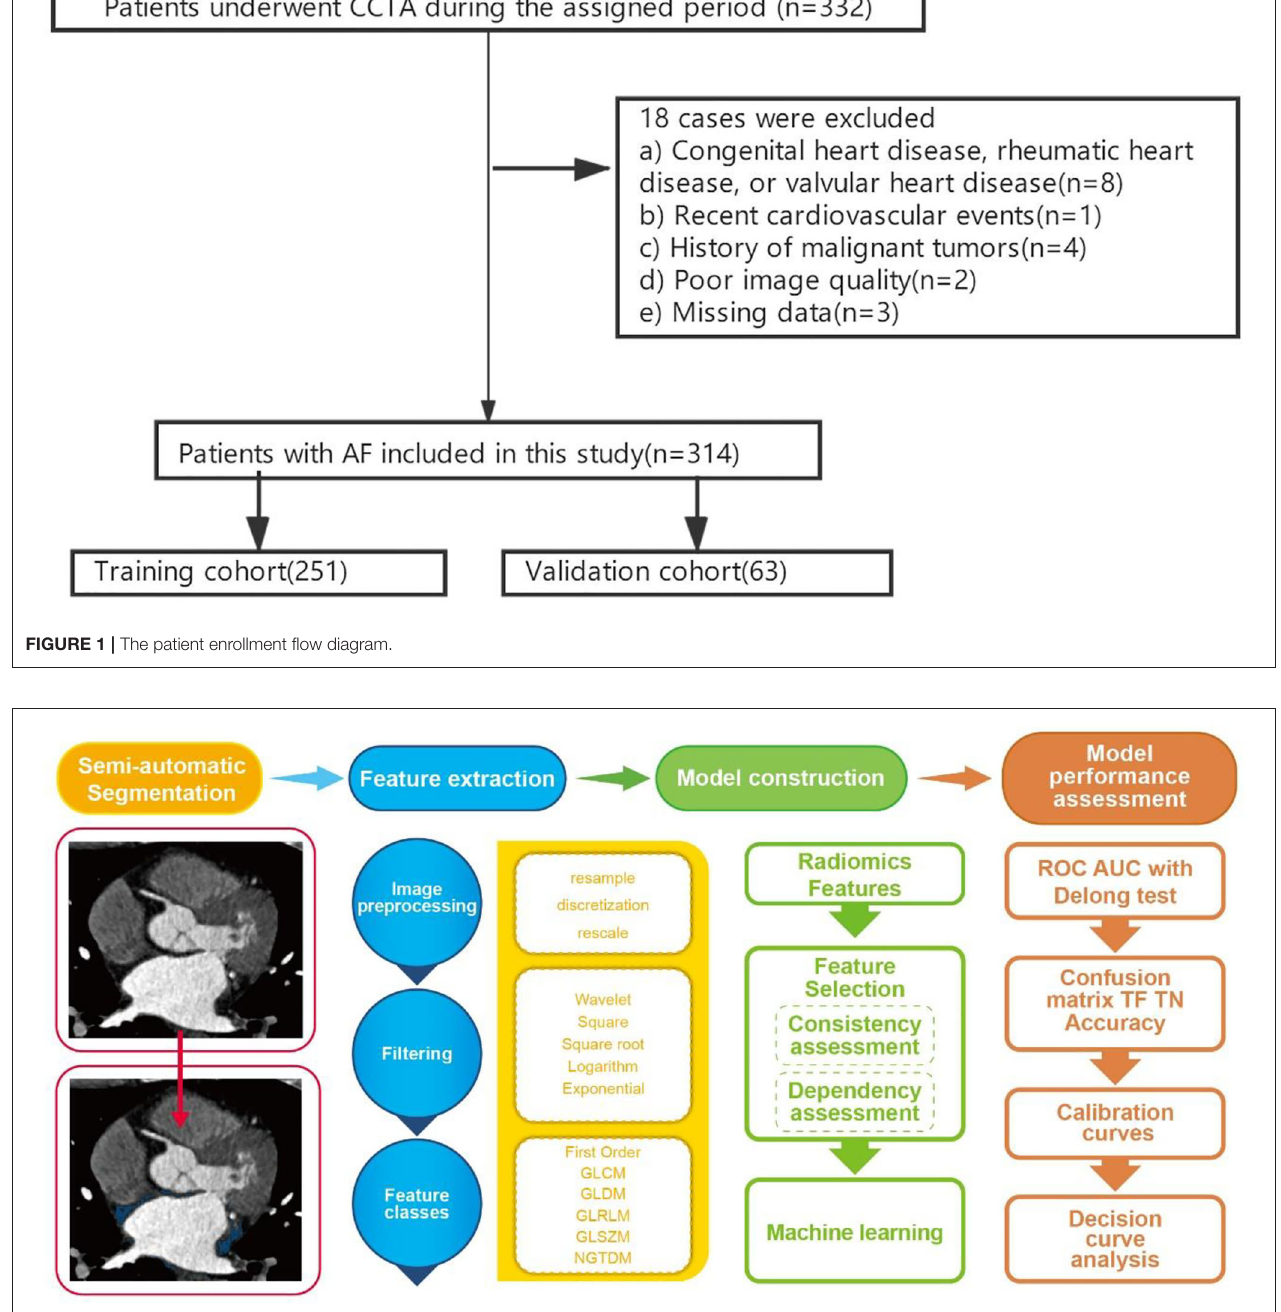
FIGURE 2 | Flowchart of the current study.